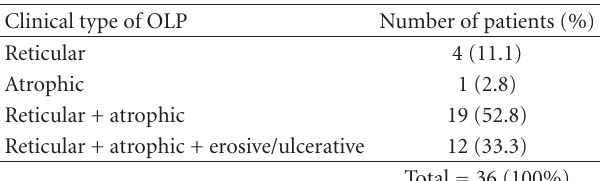
Figure 1: Clinical features of oral lichen planus manifested as keratotic, atrophic, and erosive components in buccal mucosa. Table 1: Frequency of clinical types of oral lesions in the OLP